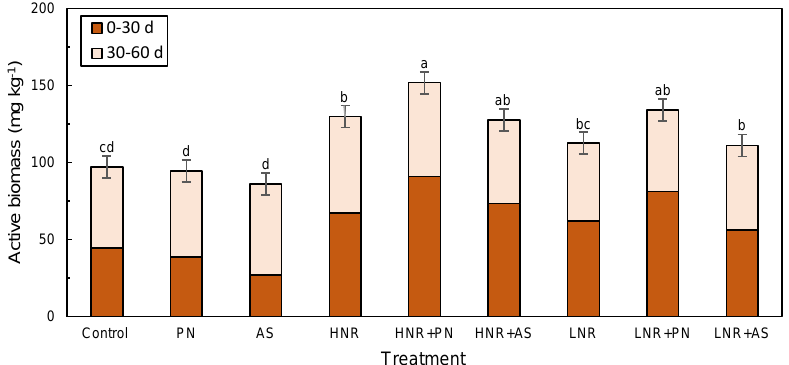
Figure 5. Active biomass measured at five intervals (7, 14, 30, 45, and 60 d) during a 60 d aerobic incubation involving an unamended control and the following eight treatments: potassium nitrate (PN), ammonium sulfate (AS), high N residue (HNR) with or without PN (HNR + PN) or AS (HNR + AS), and low N residue (LNR) with or without PN (LNR + PN) or AS (LNR + AS). Data for each incubation interval shown as a mean from duplicate subsamples with standard error bars. Statistical analyses were performed after averaging data for all five intervals, and treatments do not differ significantly ( p < 0.05) when bars are accompanied by the same letter.